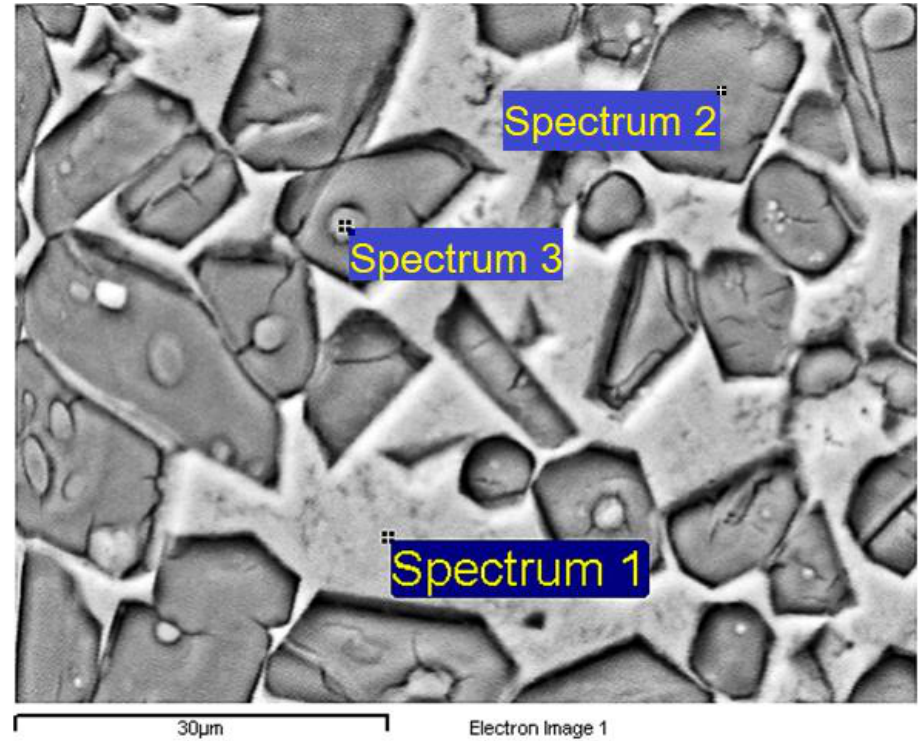
Figure 15. Round belite of P 71A_1450 remained within alite crystals at 1700×.